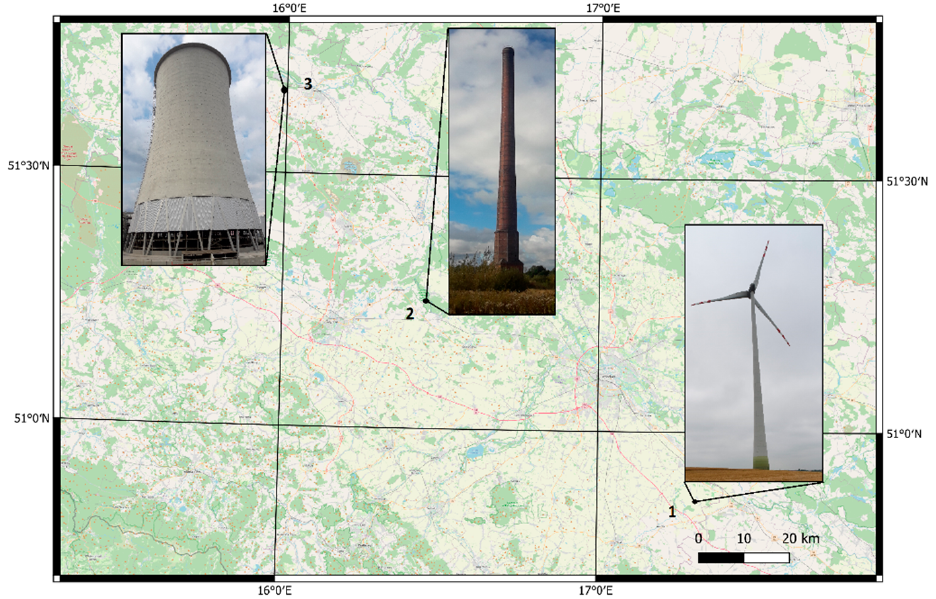
Figure 3. Location of the surveyed objects on the map: (1) wind turbine, (2) smokestack, and (3) cooling tower. Map in the background: Open Street Map (http://www.openstreetmap.org, accessed on 23 November 2021). Table 1. Characteristics of the measured objects.